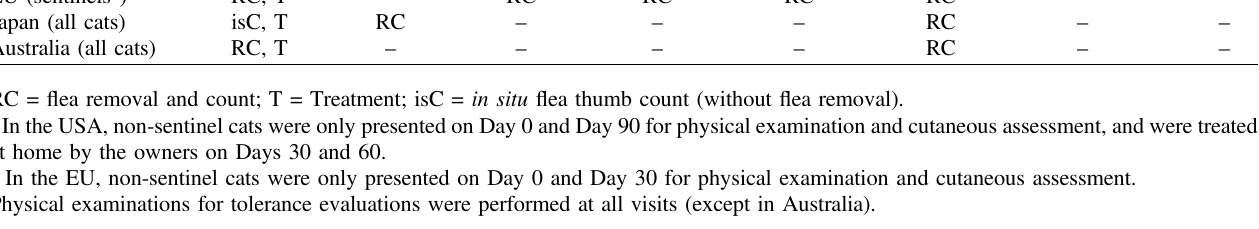
Physical examinations for tolerance evaluations were performed at all visits (except in